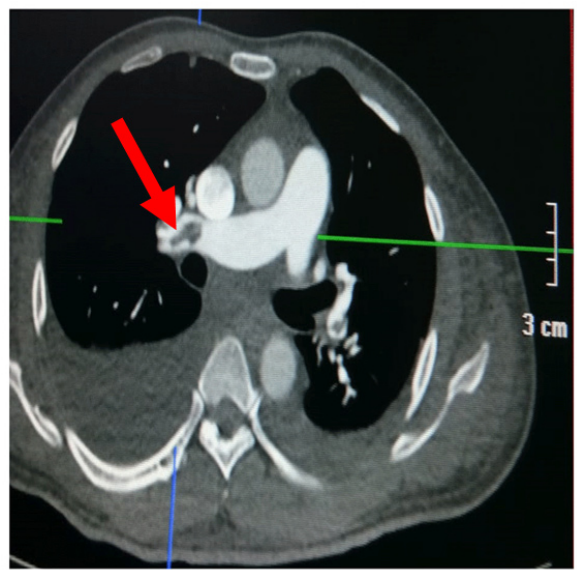
valve.Figure 5. Chest CT scan of the patient. Red arrow showing the location of the